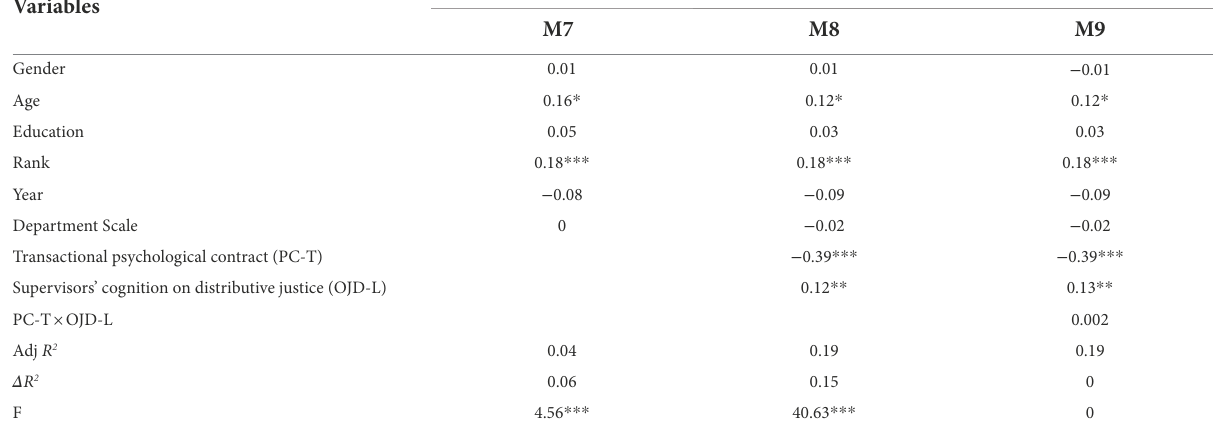
TABLE 7 The moderating effect of OJD-L to the relationship between PC-T and OI.